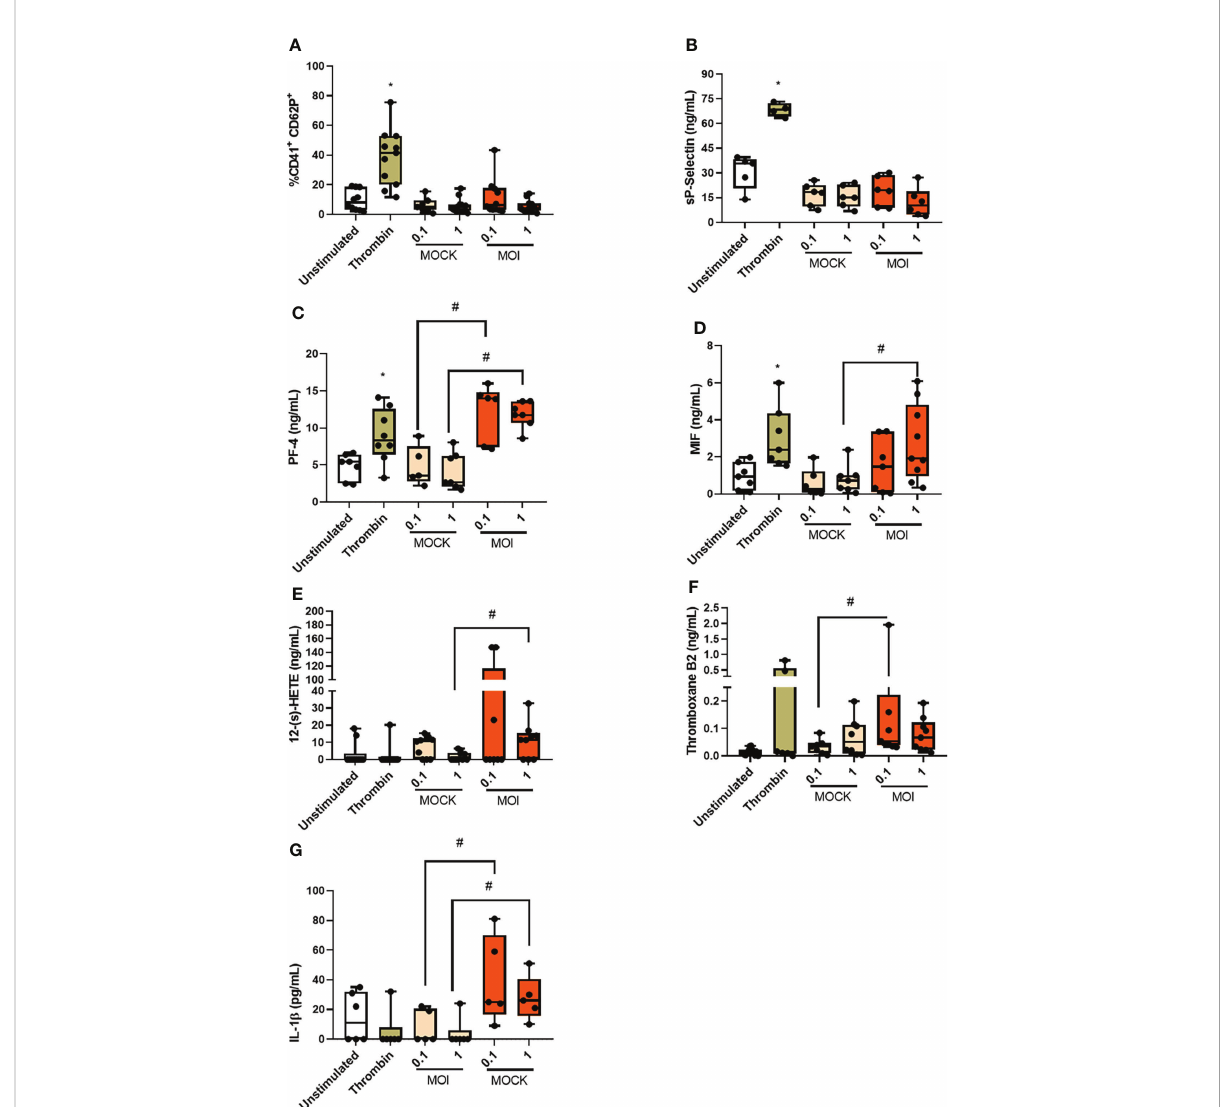
FIGURE 3 Chikungunya virus infection leads to platelet activation in vitro. Platelets from healthy donors were infected with chikungunya virus at MOIs of 0.1 and 1 for three hours. (A) Analysis of CD62P expression on platelet surface by fl ow cytometry; (B) Quanti fi cation of soluble CD62P in the supernatant of infected platelets ; (C) Quanti fi cation of platelet factor 4 (PF-4) in the supernatant of infected platelets; (D) Quanti fi cation of Macrophage migration inhibitory factor (MIF) in the supernatant of infected platelets; (E) Quanti fi cation of 12-(s)-HETE in the supernatant of infected platelets; (F) Quanti fi cation of Thromboxane in the supernatant of infected platelets and (G) Quanti fi cation of IL-1 b in the supernatant of infected platelets. *P ≤ 0.05 comparing to CHIKV with Control and # P ≤ 0.05 comparing to CHIKV with